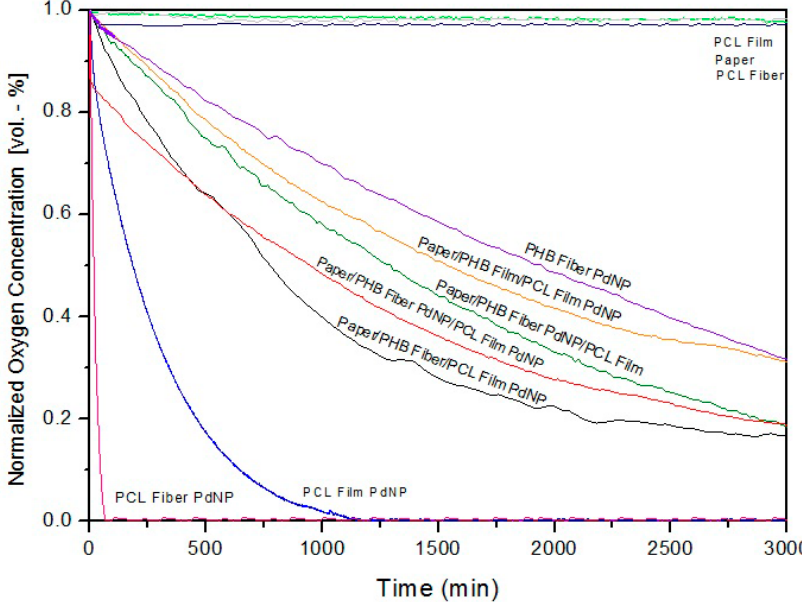
Figure 13. Oxygen depletion of PCL and PHB fibers, and paper/PHB/PCL multilayers and films with and without palladium nanoparticles (PdNPs). Values were measured at 50% relative humidity (RH).